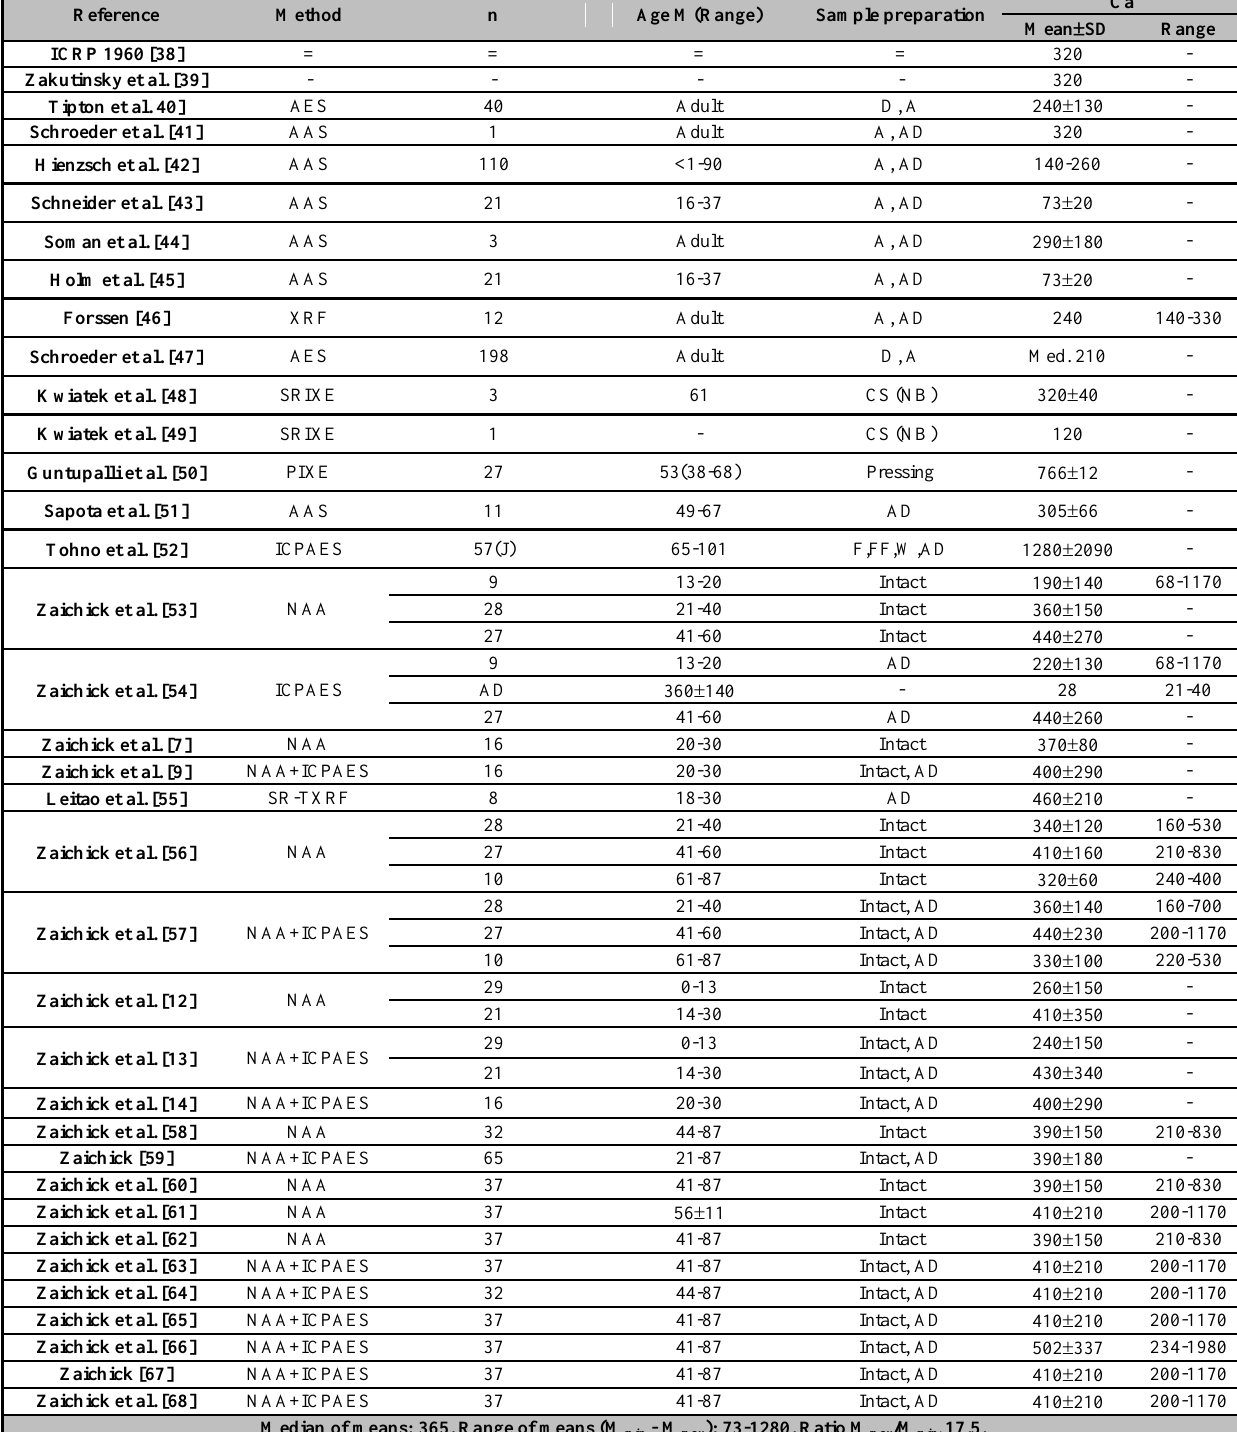
Table 1. Reference data of Ca mass fractions (mg/kg wet tissue) in “normal” human prostatic